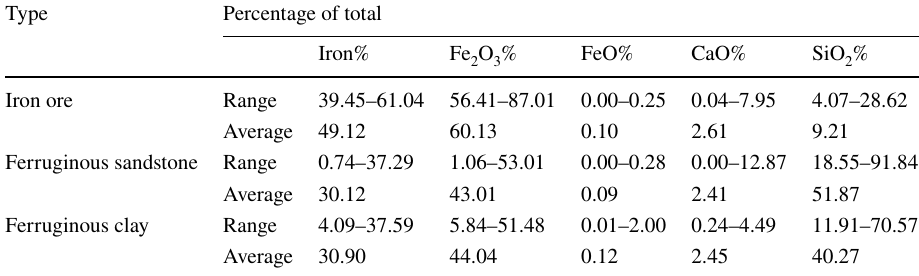
Table 1 Chemical analyses of east Aswan iron ore deposits (after Nakhla and Shehata 1967)